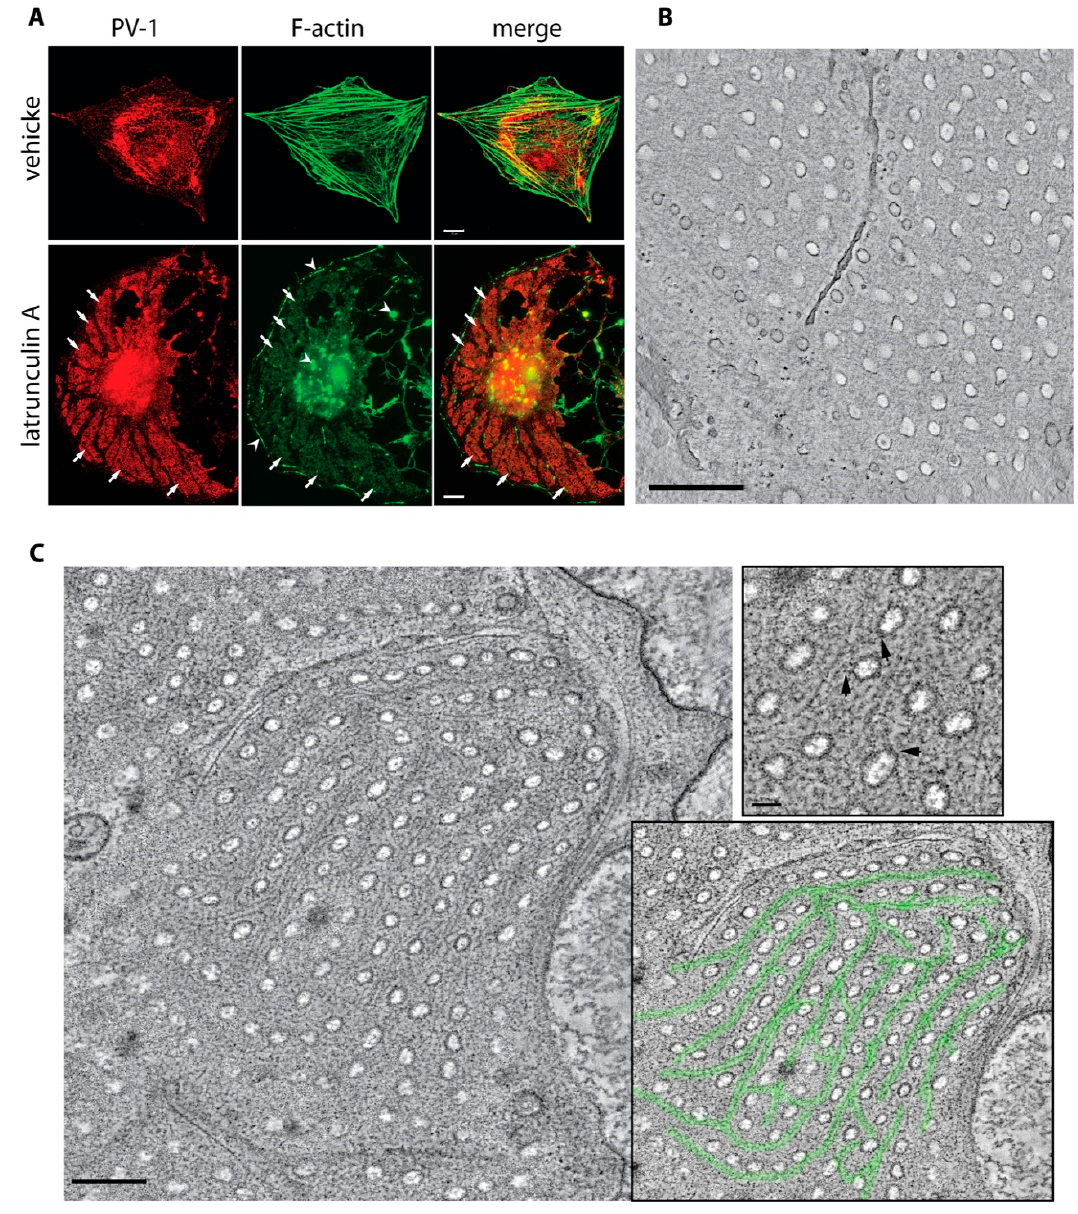
Figure 4. Organisation of the actin cytoskeleton in the fenestral sieve plates. ( A ) bEND5 cells treated with vehicle or induced with LtA for 3 h were fixed and immunostained for PV-1, and F-actin was revealed using fluorescence phalloidin. Although F-actin filaments were disassembled following induction, weaker phalloidin staining was consistently present in PV-1-positive fenestral sieve plates (arrows), suggesting the presence of short actin filaments that were beyond the resolution of light microscopy. Scale bar, 10 µm. ( B ) No discernible cytoskeletal structure was observed in tomographic projections from chemically fixed bEND5 cells (scale bar, 1 µm) (see also Video S1A), but a lattice-like cytoskeleton ( C ) was consistently observed in tomographic projections from high-pressure frozen and freeze substituted bEND5 cells (left panel, highlighted in green; scale bar, 500 nm) (see also Video S1B). A cytoskeleton that runs proximal and parallel to the linear arrays of fenestral pores in sieve plates is shown at high magnification. Links between the actin cytoskeleton and the rim of the fenestral pore were sometimes distinguishable (arrows in top right panel of C ; scale bar 50 nm). The network in an image of the sieve plate is traced in the bottom-right panel of C . Spectrin was first identified in erythrocytes [19] and was subsequently identified in nonerythroid cells [25,26], where it is referred to as fodrin. The spectrin membrane skeleton is localised immediately under the plasma membrane and enables membrane distensibility and